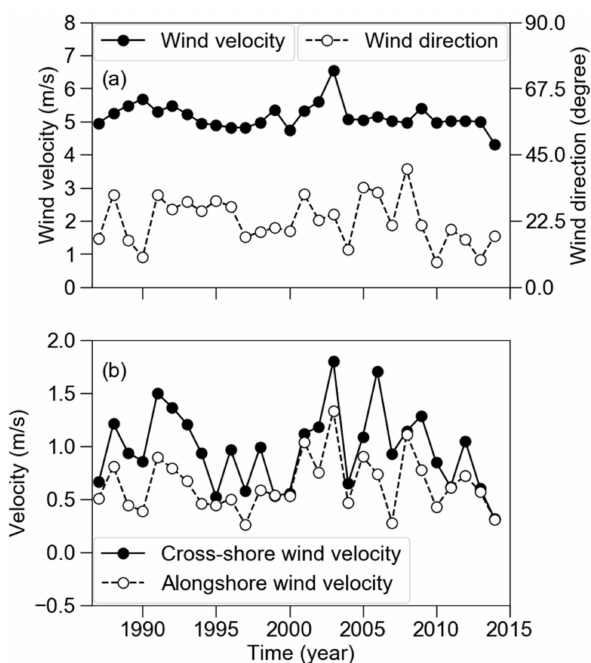
Figure 7. Yearly averaged wind characteristics. See Figure 6 for further explanation.